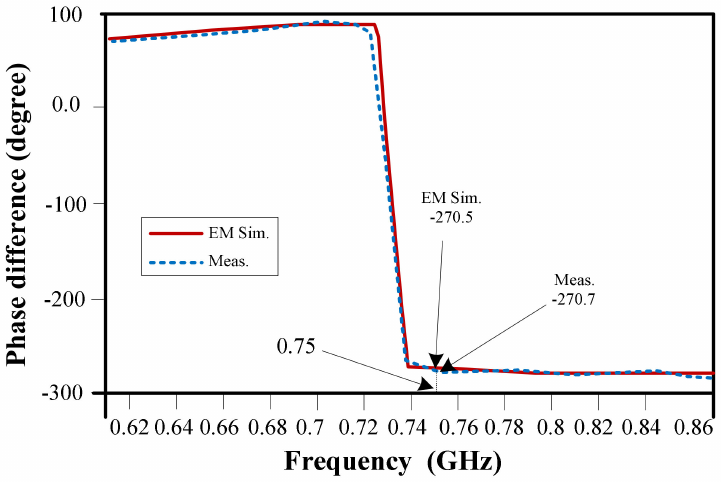
Figure 18. Measurement and EM simulation of the output ports’ phase difference.